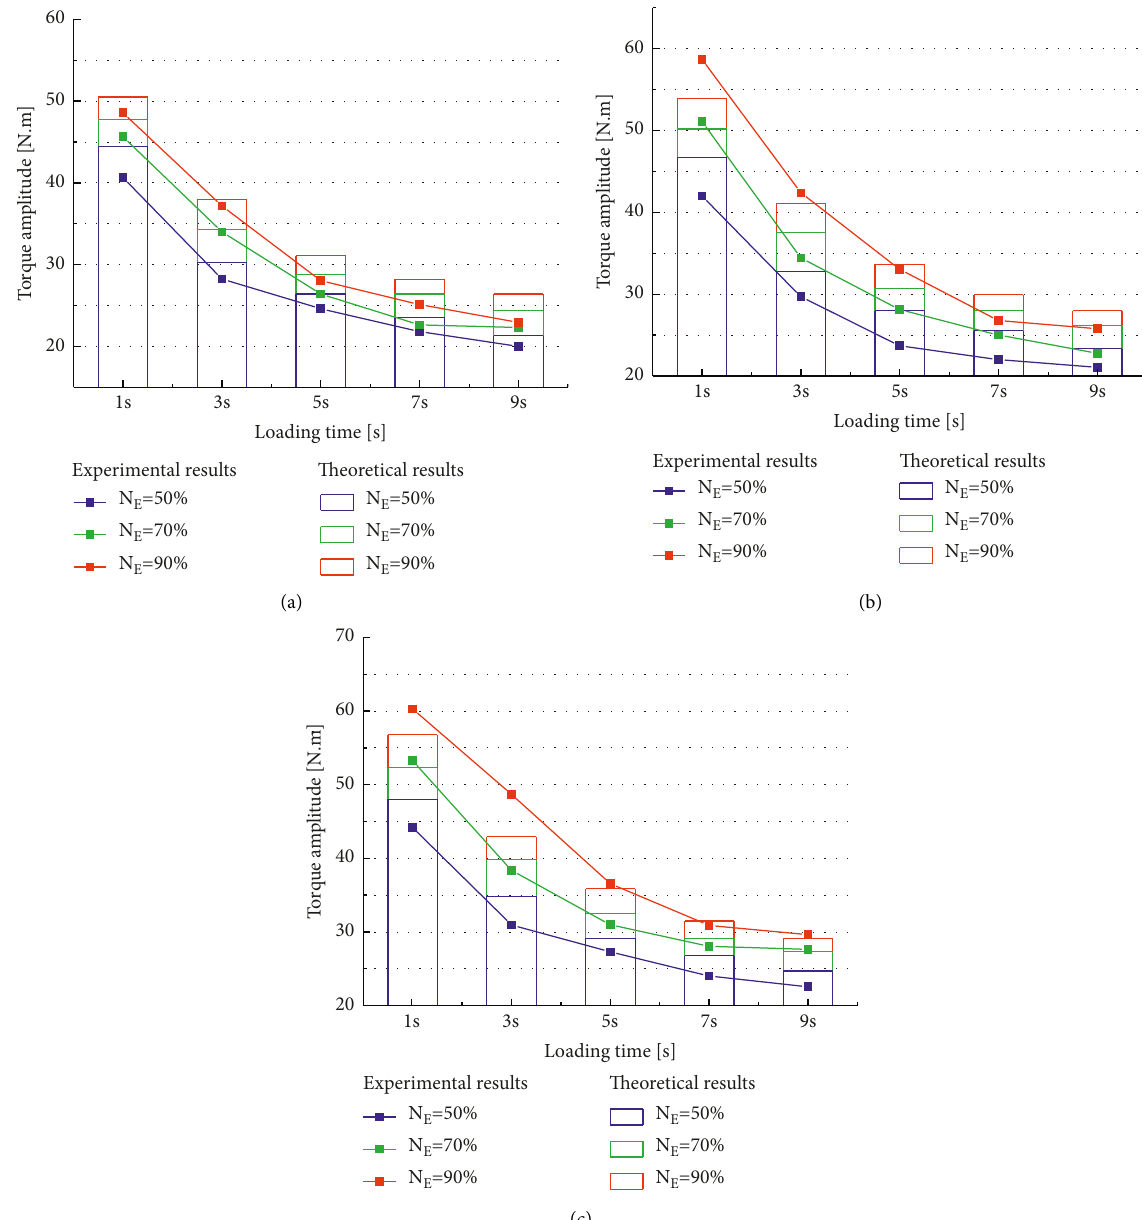
Figure 14: Measured torque response amplitudes for different engaging parameter values: (a) N